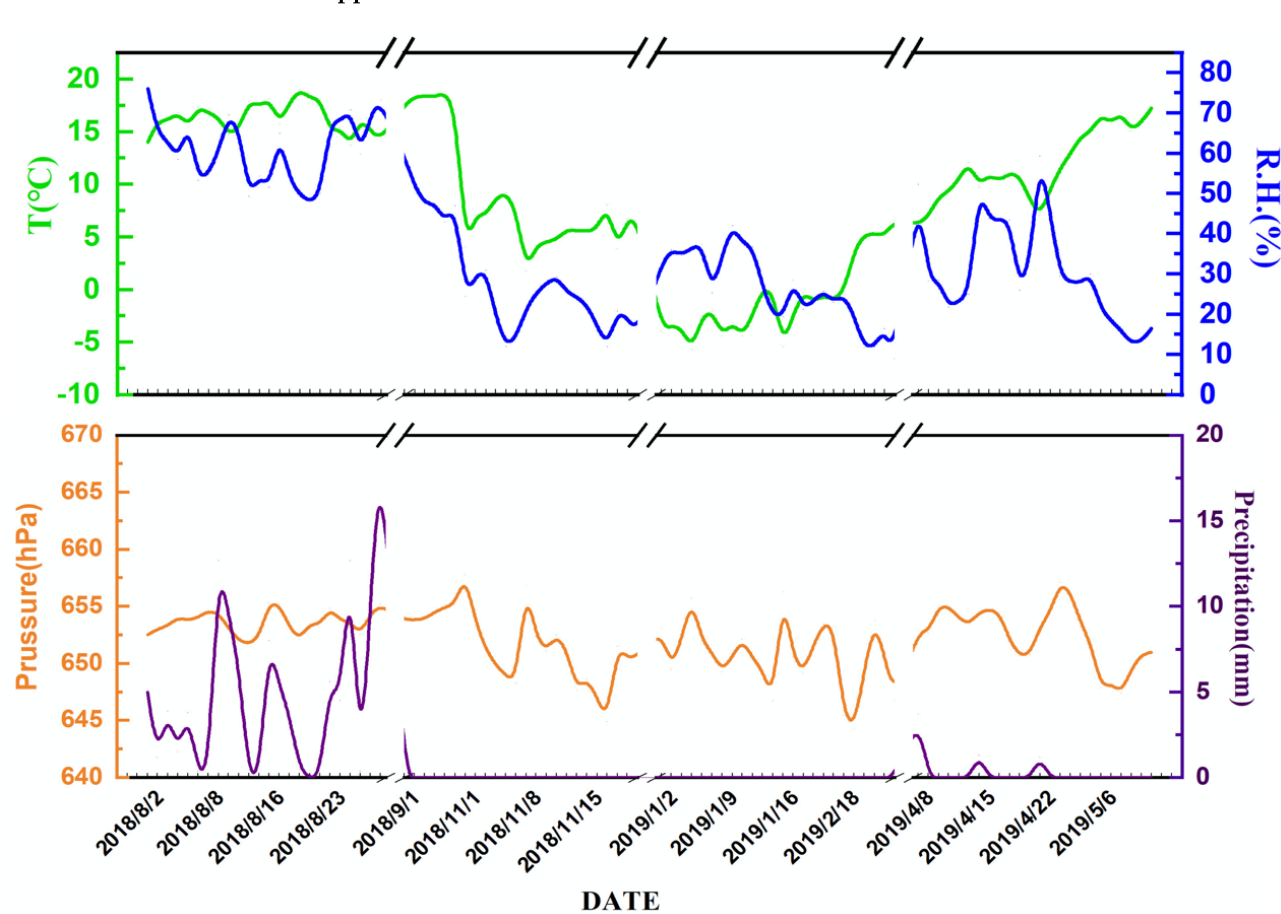
Figure A1. The characteristics of the meteorological parameters in Lhasa Station during sampling. Table A1. Comparison of the mass concentrations of TEs (PM 3 ) with other cities in China. Location